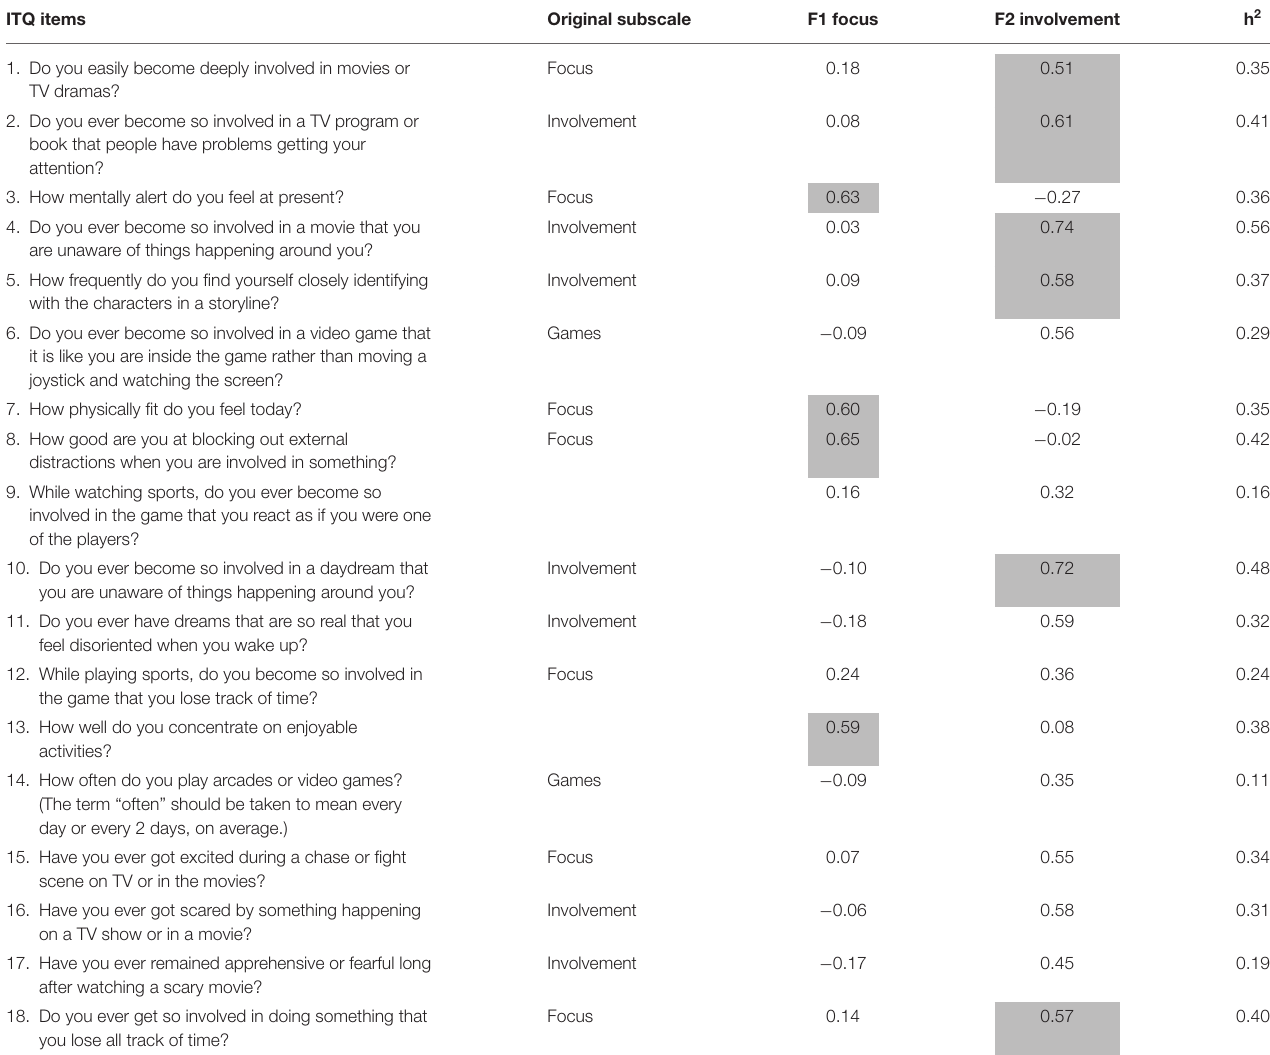
TABLE 4 | The factor structure of the 18-item version of the ITQ. ITQ